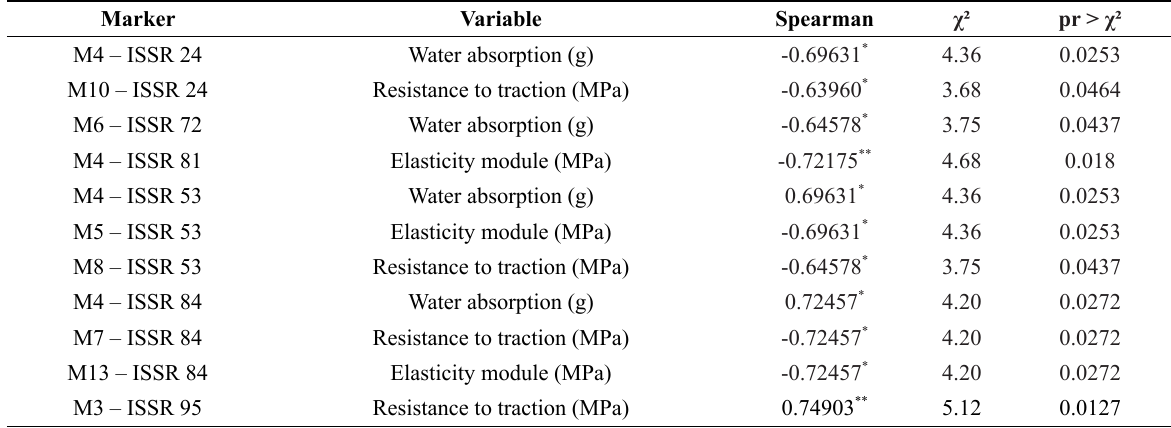
Spearman and Kruskal-Wallis correlation used to analyze the association between molecular markers and fiber quality variables of 11 pineapple